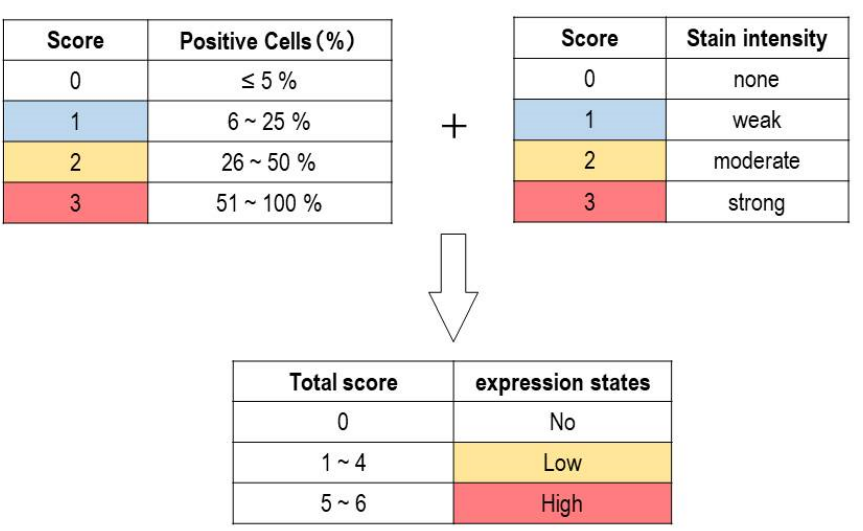
Figure 1. Immunohistochemical assessment of p16 in adult T-cell leukemia/lymphoma (ATLL) and peripheral T-cell lymphoma, not otherwise specified (PTCL-NOS). Evaluation criteria for staining score. The total score was calculated by adding the staining intensity score (0–3) and positive cell percentage score (0–3). The total score was stratified into three groups: no expression (score 0), low expression (score 1–4), and high expression (score 5–6).